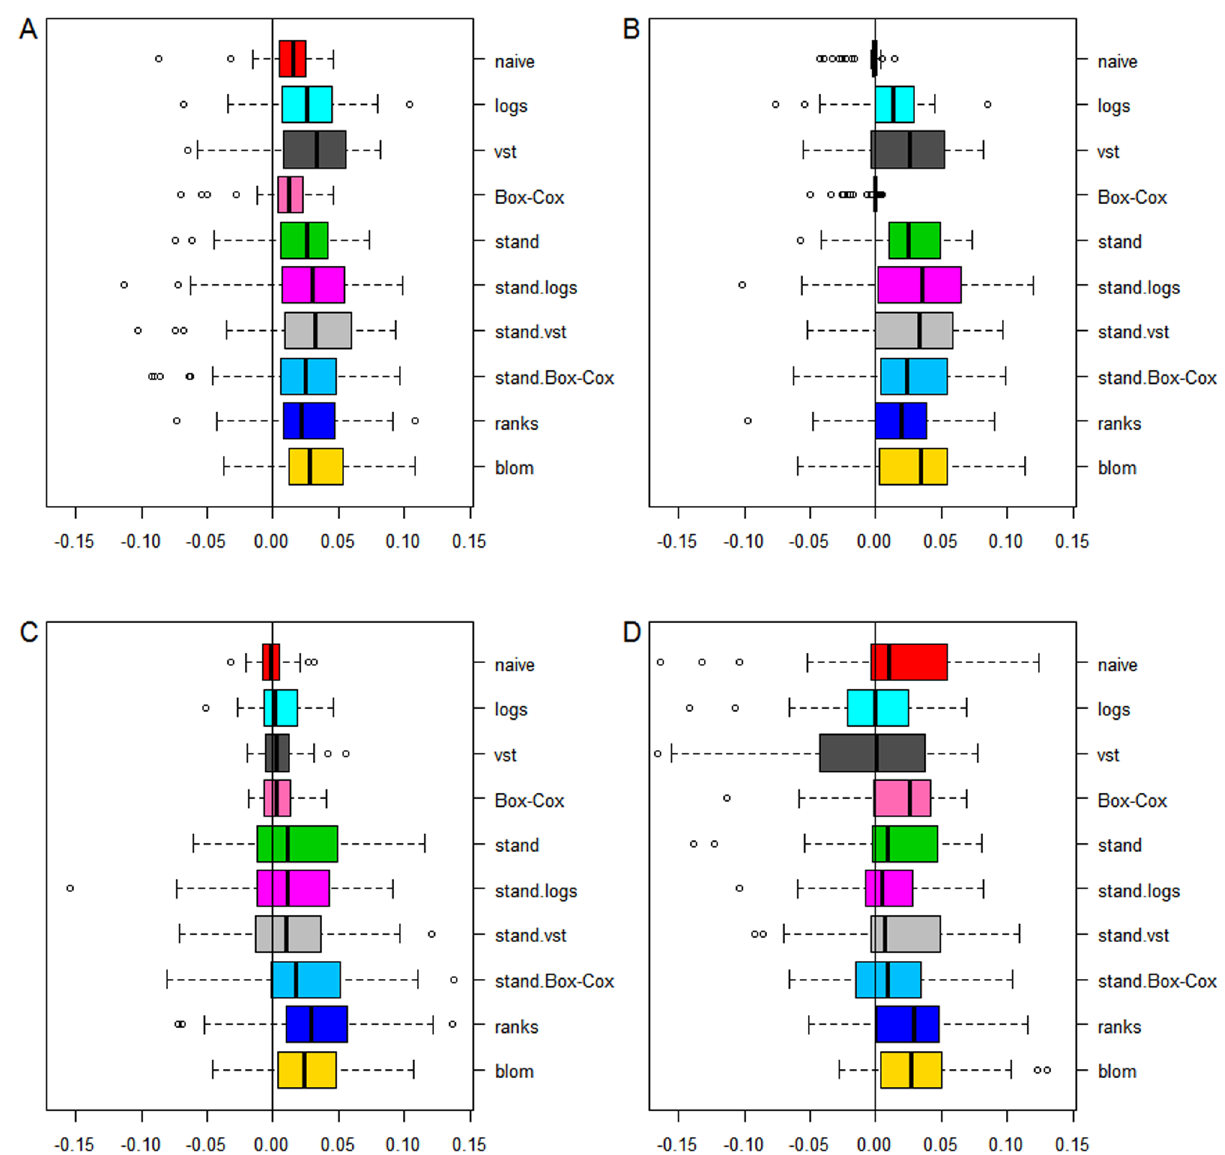
Figure 6. Added value for KIRC and AML data. Positive added values indicate improvement in prediction error. A: CoxBoost model used for prediction on KIRC data. B: Lasso used for prediction on KIRC data. C: CoxBoost model used for prediction on AML data. D: Lasso model used for prediction on AML data.